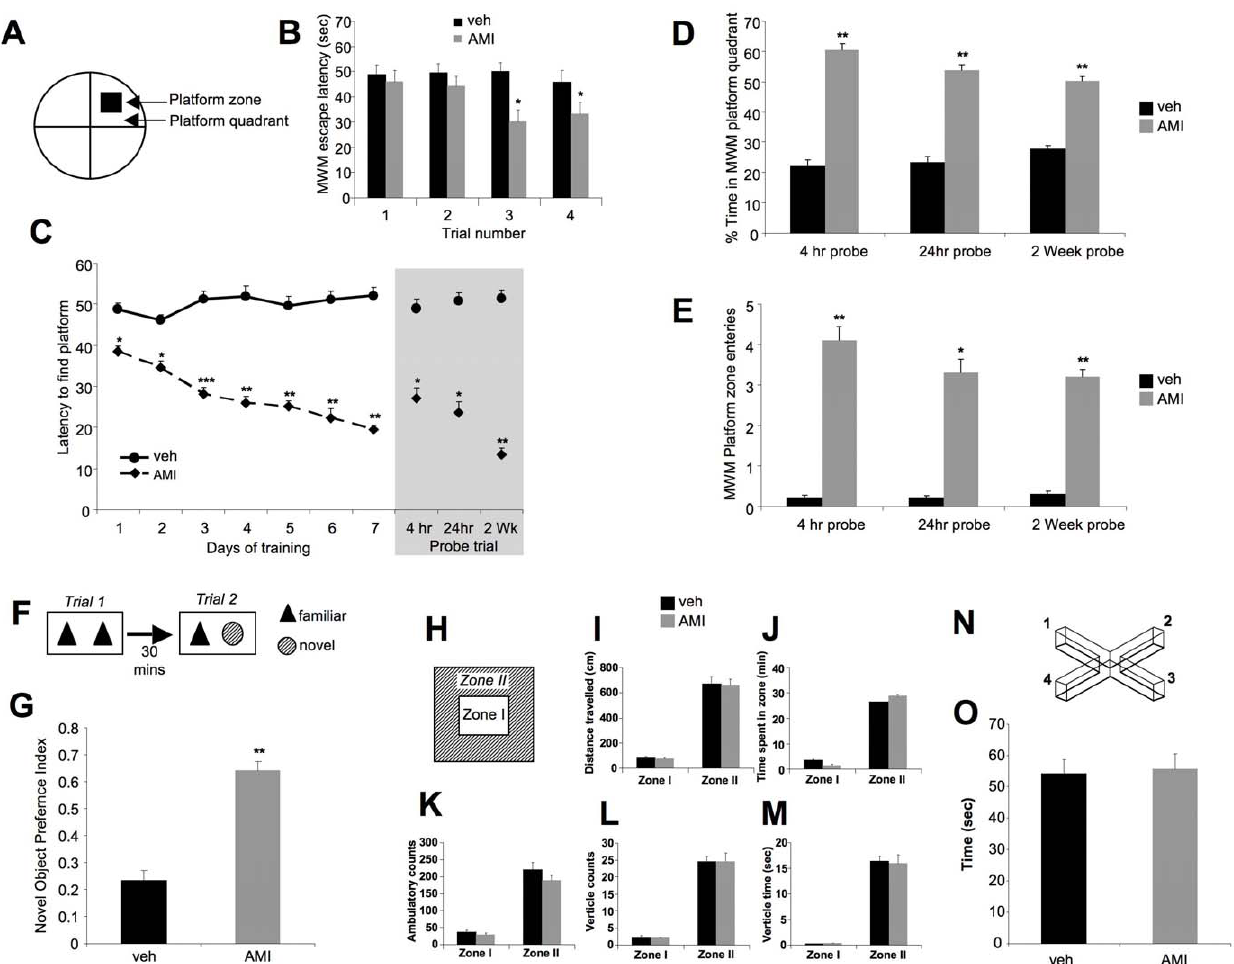
Figure 3. AMI improves learning and memory in 3 6 TgAD mice. (A) Morris water maze (MWM) used. (B) AMI/veh effects upon day 1 platform escape latency. (C) AMI/veh effects upon MWM platform acquisition measured by escape latency in seconds. Grey panel indicates 3 time points after the seventh day of MWM testing for the probe trial, as described in Methods . (D) AMI effects upon time spent in MWM platform quadrant during 3 probe trial time periods after MWM acquisition. (E) AMI effects upon number of platform traverses during the 3 probe trial time periods after MWM acquisition. (F) Novel object preference (NOP) protocol. (G) AMI/veh effects upon 3 6 TgAD NOP index. (H) Open field test employed. AMI/veh or effects on open field performance: distance traveled (I); time spent in specific zone (J); total ambulatory activity counts (K); vertical activity counts (L) and total vertical activity time (M). (N) Elevated plus maze employed (arms 1 and 3=dark). (O) AMI effects upon total time spent in open arms 2 and 4.